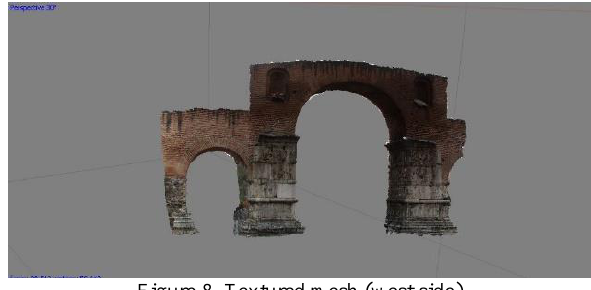
Figure 8. Textured mesh (west side)